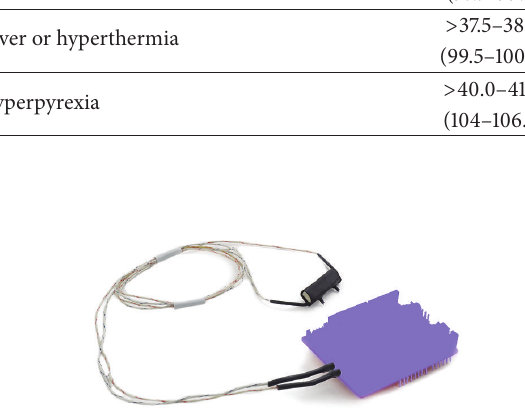
Figure 5: Airflow sensor (adapted from [12]).